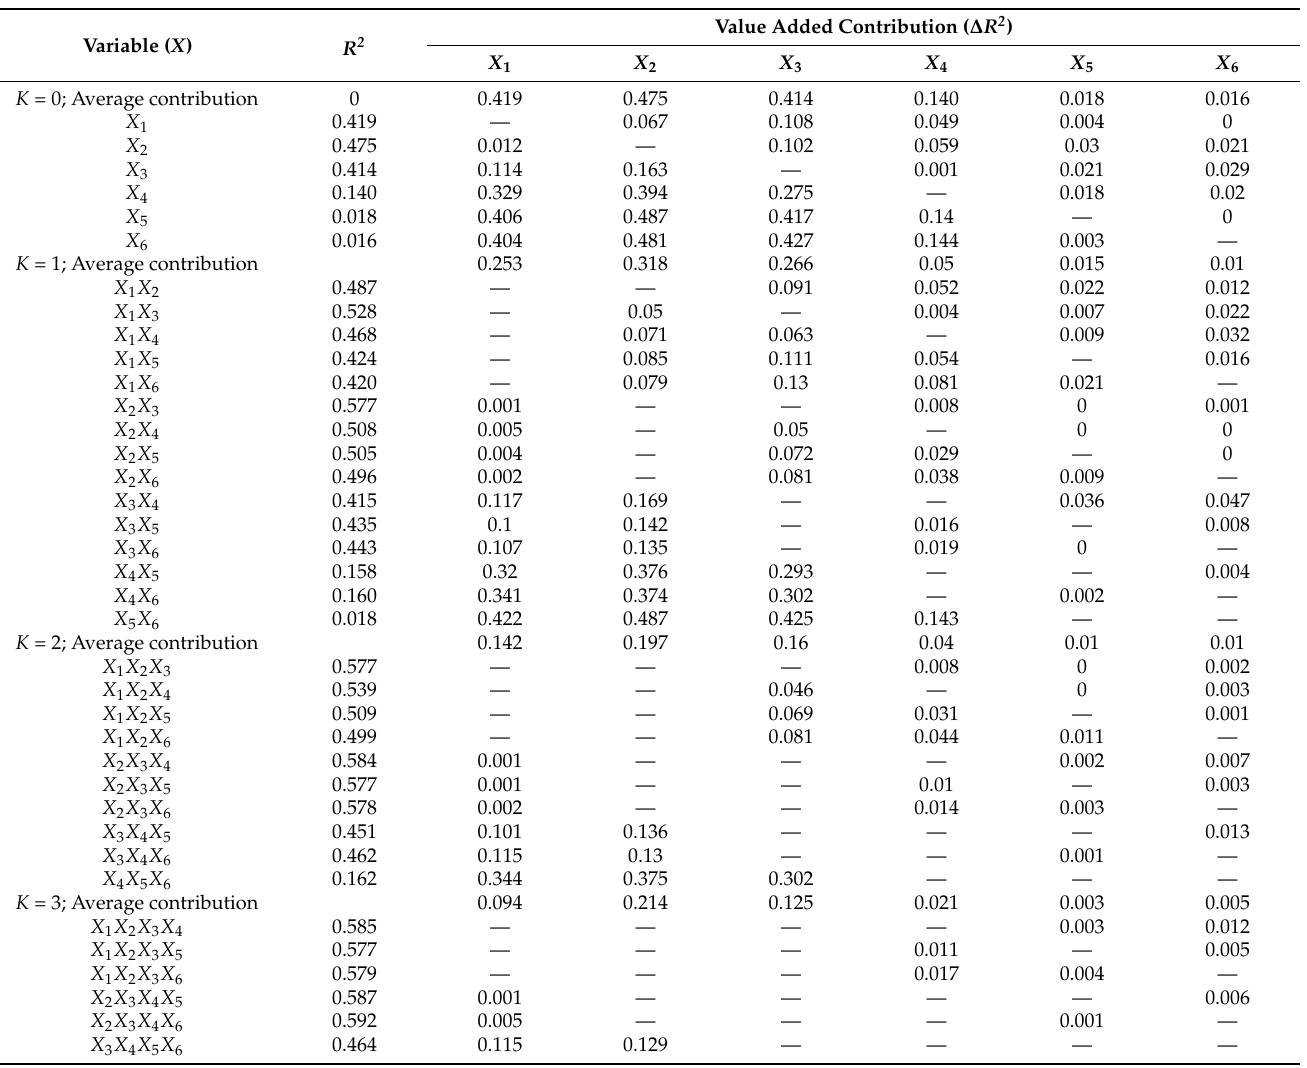
Table 2. The contributions of the influencing factors to the variance of the permafrost area (Note: K denotes the number of predictor variables included in the sub-model; X 1 : annual average snow depth; X 2 : annual average snow cover; X 3 : annual average NDVI; X 4 : annual average solar radiation; X 5 : annual average precipitation; X 6 : annual average 0–7 cm soil water).